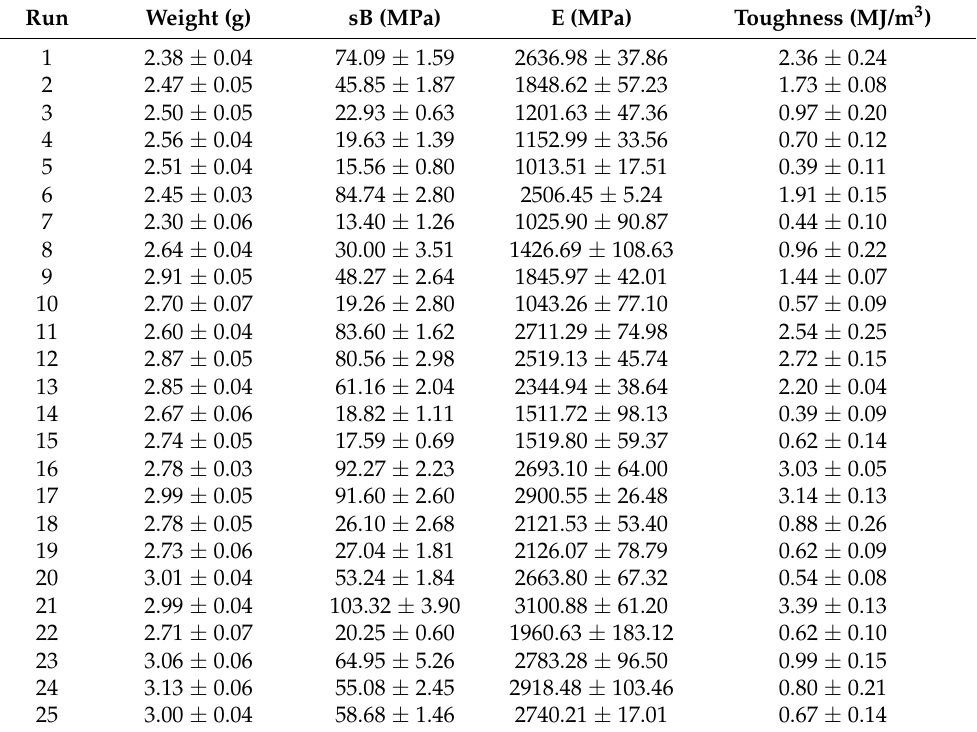
Table 2. Average and standard deviations values of measured responses for weight, flexural strength (sB), flexural modulus of elasticity (E), and flexural toughness.